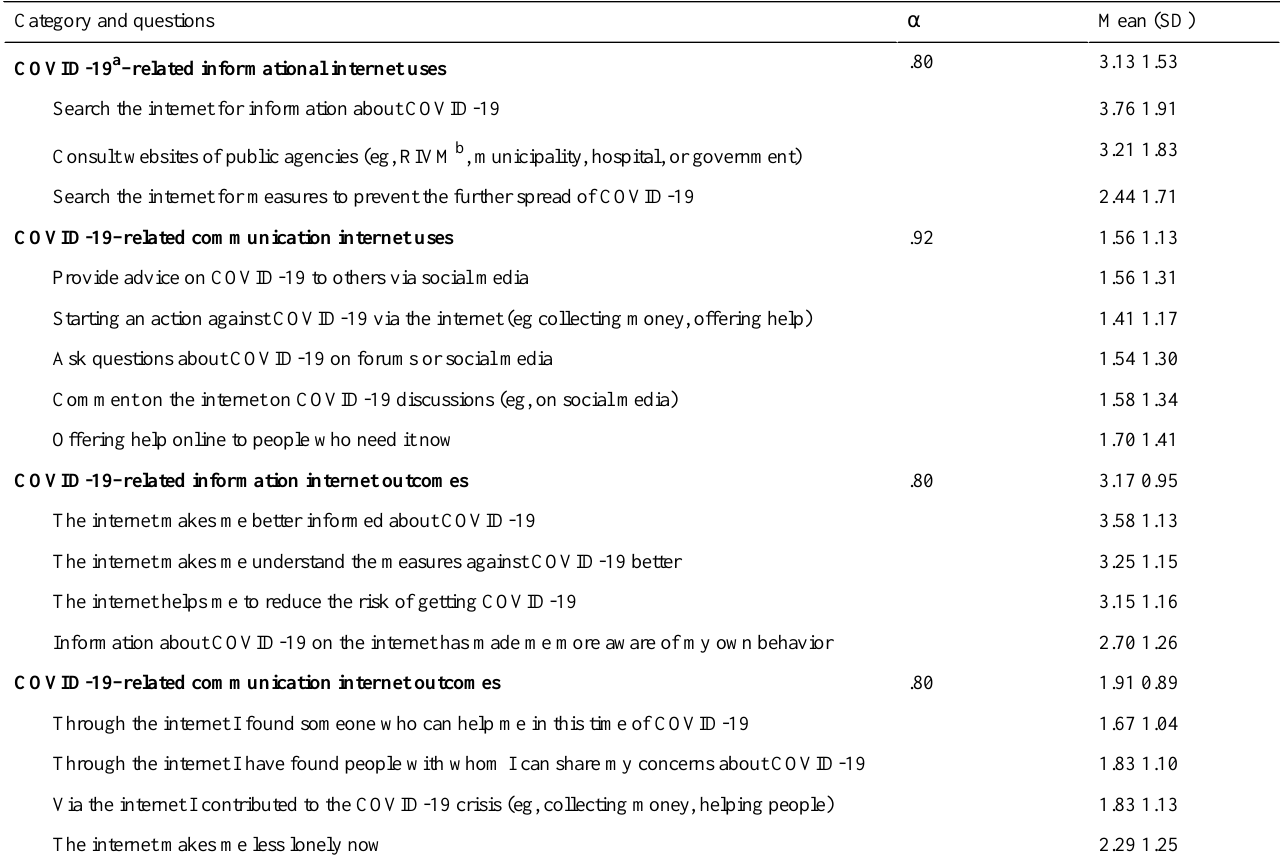
Table 2. Survey questions and responses on the 5-point Likert